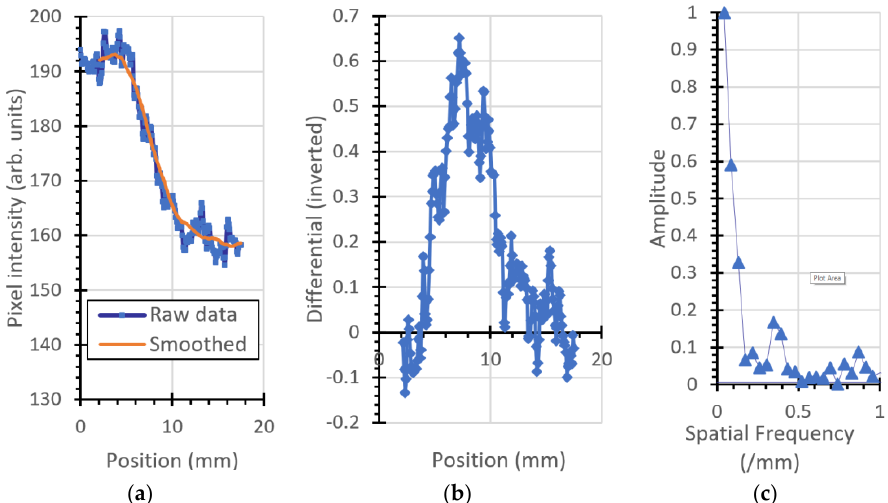
Figure 9. Vertical edge, bottom part of Adelphi’s logo: ( a ) ESF, ( b ) LSF (inverted for clarity), and ( c ) MTF.